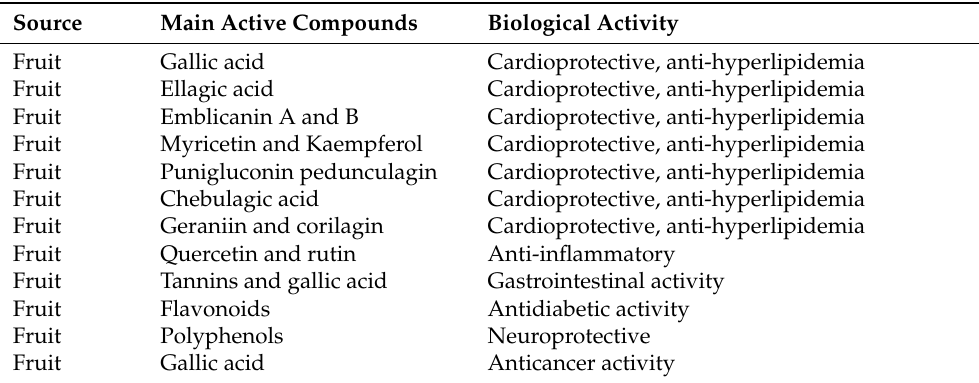
Table 5. Major phyto-constituents present in E. officinalis and their pharmaceutical effects beyond cardioprotective and anti-hyperlipidemia 1